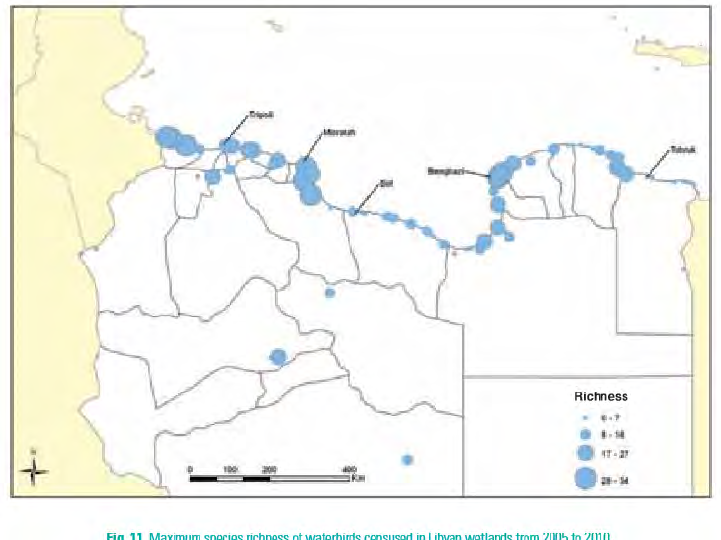
Figure 2. Maximum species richness of waterbirds censused in Libyan wetlands from 2005 to 2010.[5]. p30